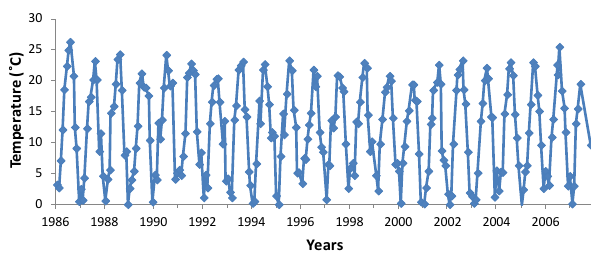
Fig. 2. Time series of water temperature at the Gwynns Falls at Villa Nova (GFVN), the urban site with longest historical data. Wa- ter temperature were recorded monthly. No trend of decrease or in- crease was observed for annual mean, maximal and minimal water temperature ( p > 0 . 05, linear